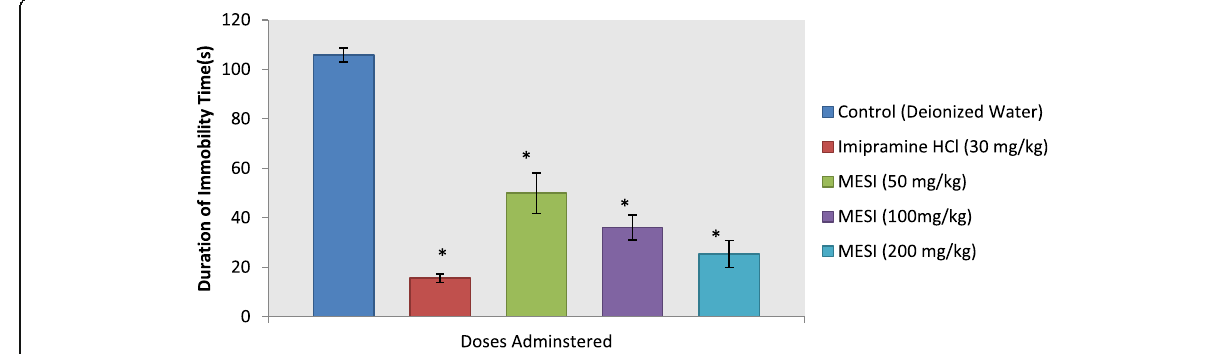
Fig. 1 Graphical presentation of the effect of MESI on immobility time in TST